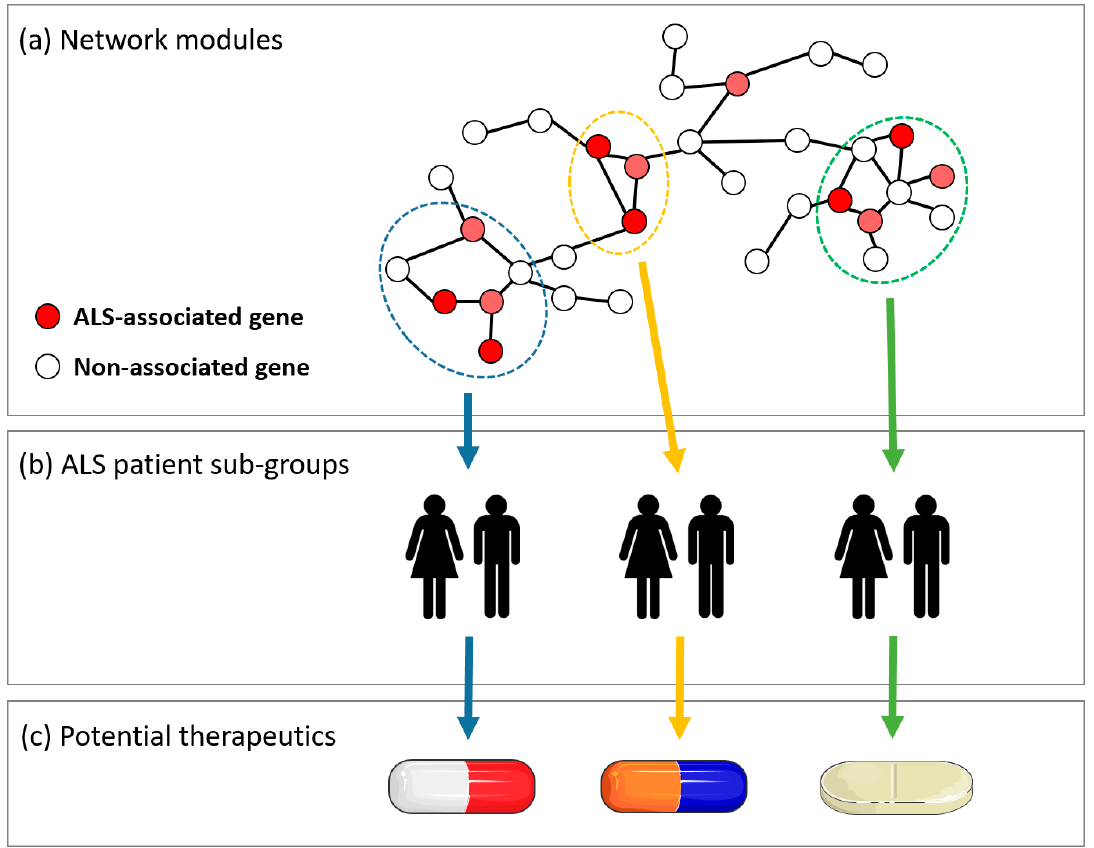
Figure 1. A central concept in the analysis of molecular interaction networks (MINs) is the identification of network modules, or clusters, of interactions that represent a process or pathway relevant to disease. The affected network module may differ between subgroups of a patient population, which could be used to develop personalized medicine approaches. ( a ) A miniature example of a MIN, with three network modules indicated in blue, green, and yellow. Within each module, specific genetic variants or biomolecules, indicated in red, are known to be associated with amyotrophic lateral sclerosis (ALS) pathology. ( b ) ALS subpopulations separated according to which module is affected or dysregulated. ( c ) Potential drug therapies can be tailored to target specific mechanisms within the ALS disease pathway, corresponding to specific patient subpopulations.